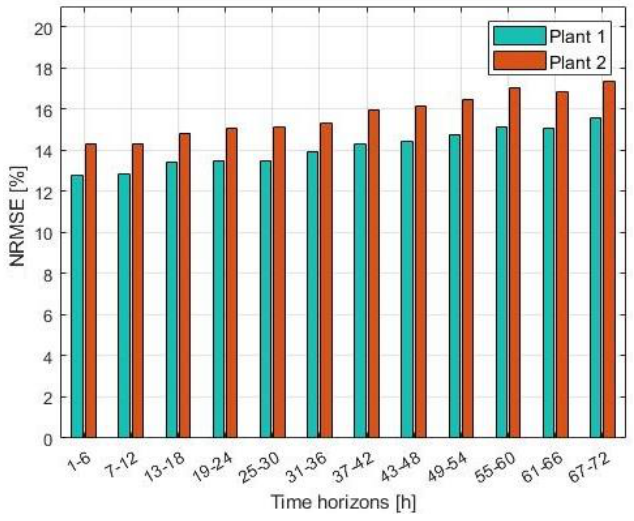
Figure 6. NRMSE with respect to Pmax for 12 different time horizons.